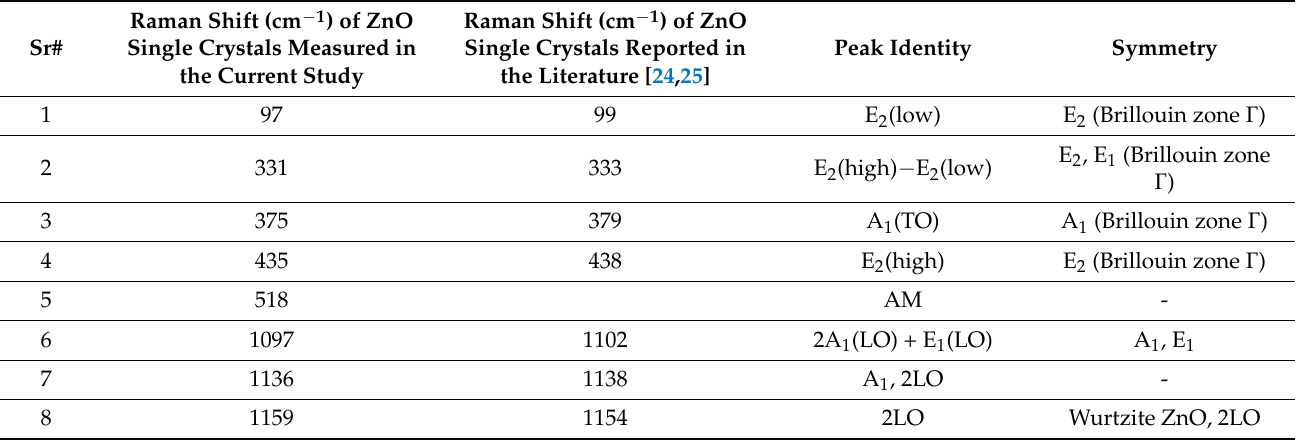
tials are higher in this orientation. No shift has been observed in the main characteristic Raman peaks in all three orientations, which indicates that all single crystals are free from extrinsic defects or impurities. The only defects in these single crystals are intrinsic